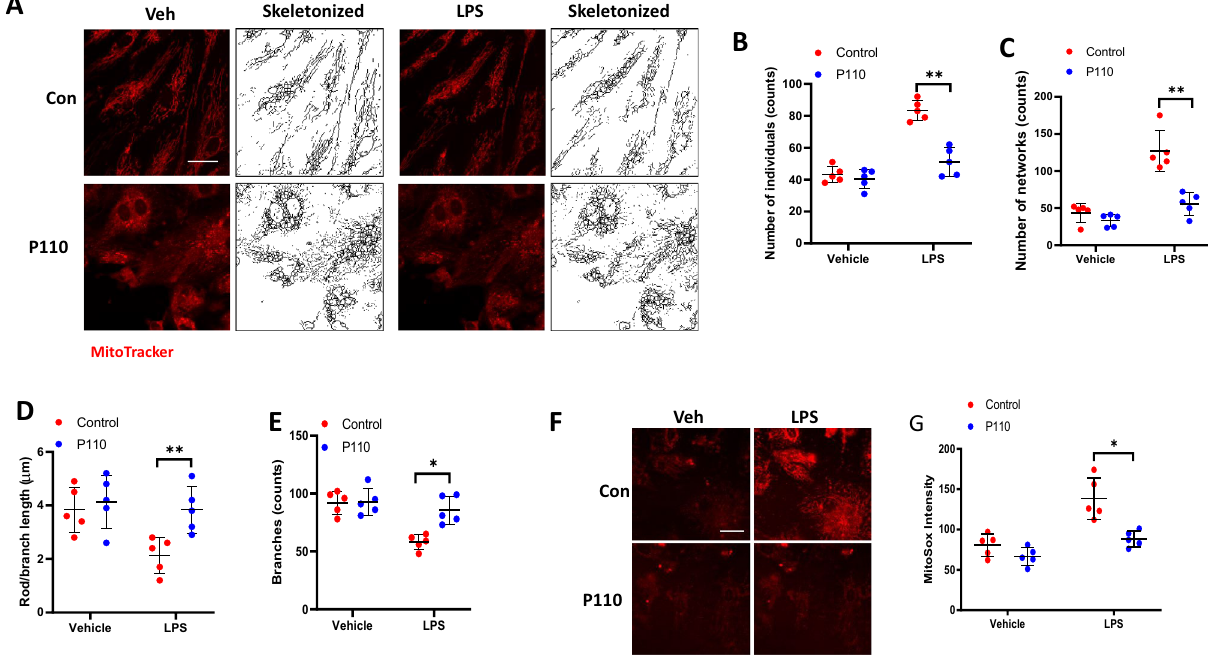
Figure 5. DRP1 inhibitory peptide blocks LPS-induced EC mitochondrial fission and ROS. ( A ) HLMVECs were pretreated with DRP1 inhibitory peptide P110 (1 µM) for 1 h followed by adding of MitoTracker 10 min before imaging. Images were acquired at 5 min intervals. After 30 min imaging of the basal level of mitochondrial morphological information, cells were treated with 100 ng/ml LPS followed by continuous imaging of mitochondria at the same intervals. Presents are images acquired before LPS treatment (Veh column) and after LPS treatment (LPS column). ( B – E ) Mitochondrial dynamics was assessed by number of individual fragments, number of networks, rod/branch length, and branch counts. Data were presented as means ± SD, for number of individual fragments, **p < 0.01, LPS alone versus LPS + P110; for number of networks, **p < 0.01, LPS alone versus LPS + P110; for rod/branch length, **p < 0.01, LPS alone versus LPS + P110; for branch counts, *p < 0.05, LPS alone versus LPS + P110. ( F ) HLMVECs were treated same as described above, instead of using MitoTracker staining, cells were treated with 5 µm MitoSOX for 10 min before imaging. Shown are representative of at least 5 images. Scale bar 10 μm. ( G ) MitoSOX intensity analysis, *p < 0.05, LPS alone versus LPS +